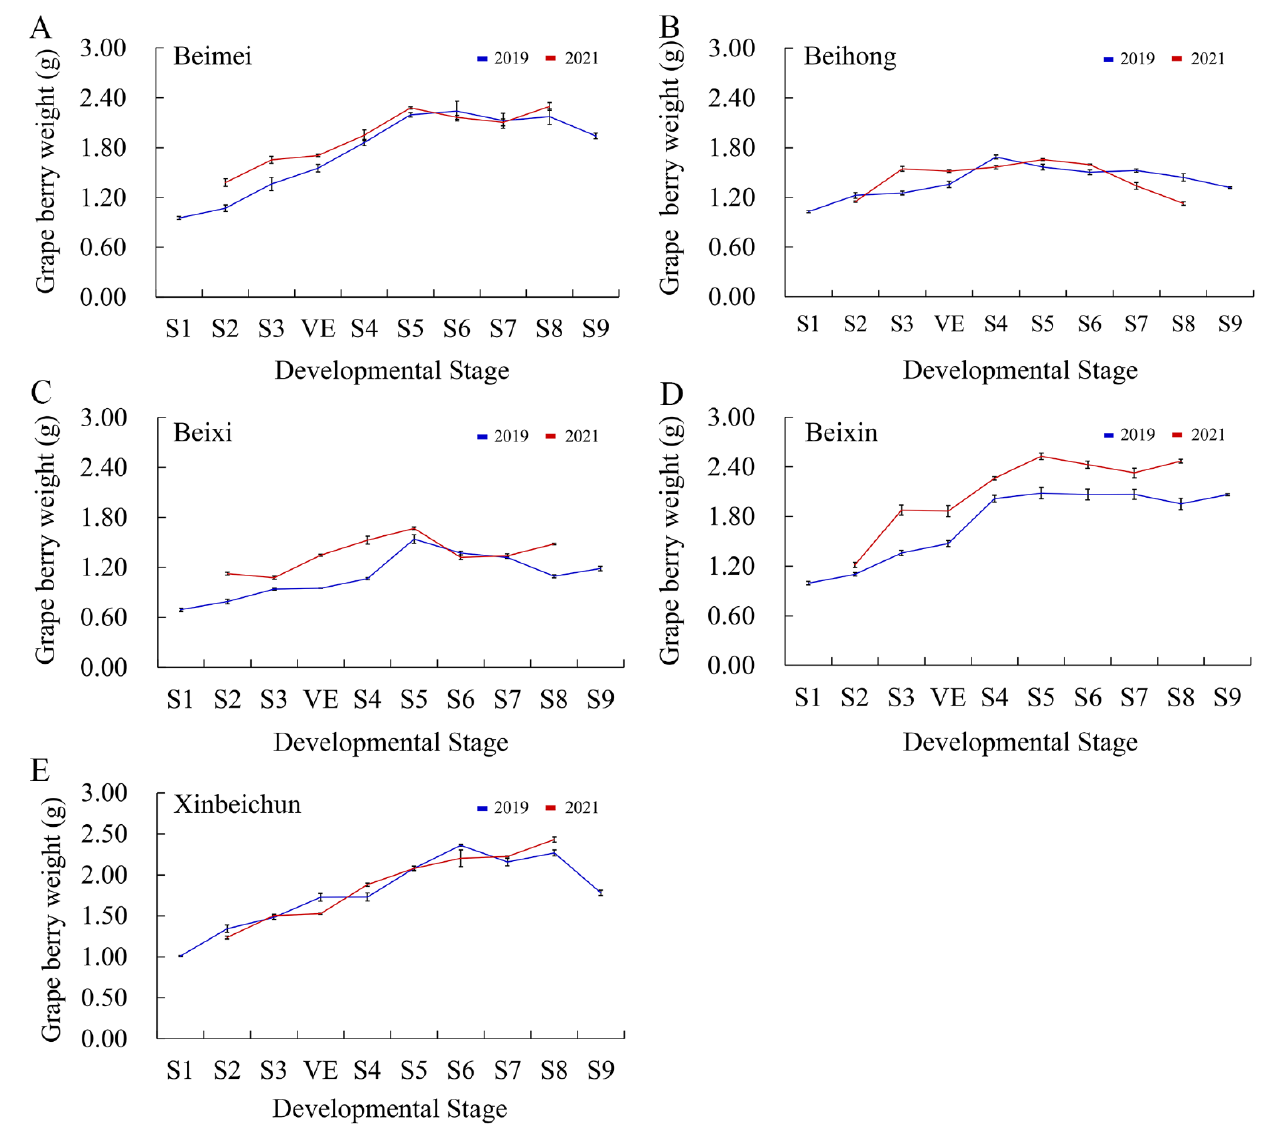
Figure 3. Berry weight changes at different stages of development of ‘Beimei’ ( A ), ‘Beihong’ ( B ), ‘Beixi’ ( C ), ‘Beixin’ ( D ) and ‘Xinbeichun’ ( E ). S1 sampling date was 19 June 2019. S2 sampling date in 2021 was 8 July. S1 – S9 were sampled once every two weeks, VE = veraison. Data are mean values of three replicates, the error bars indicate the SE from repeats.